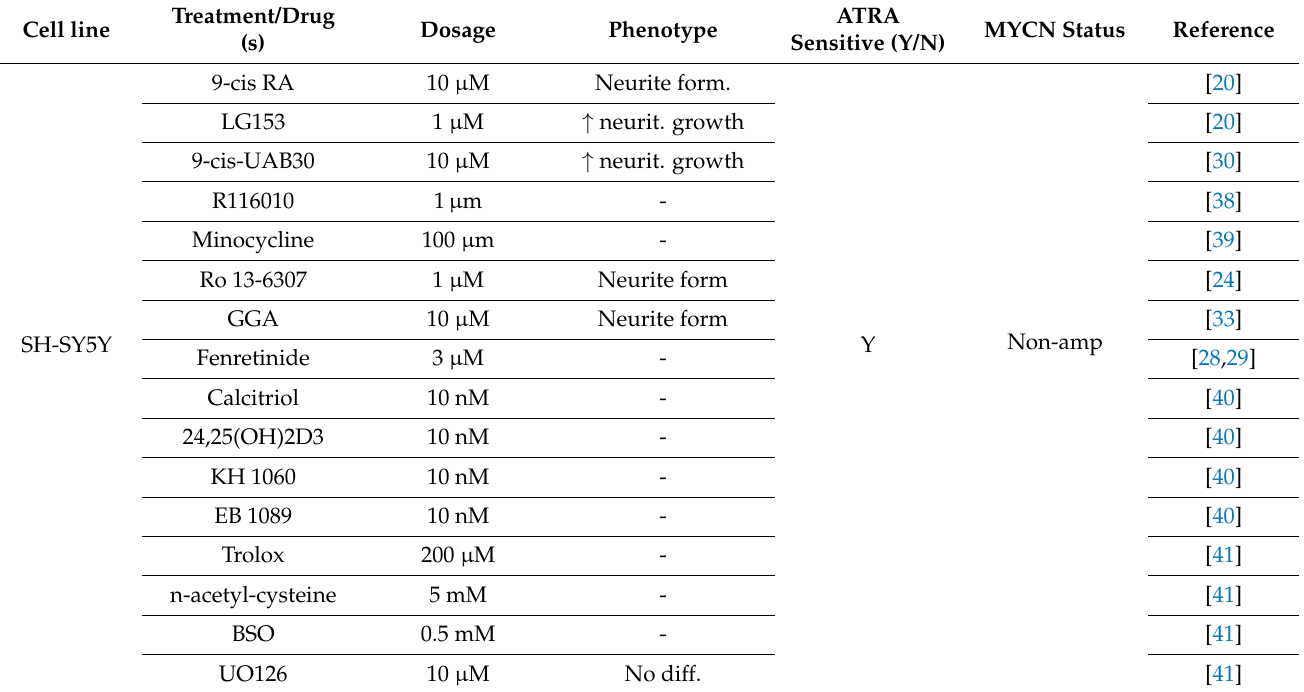
Table 3. In Vitro models and compound